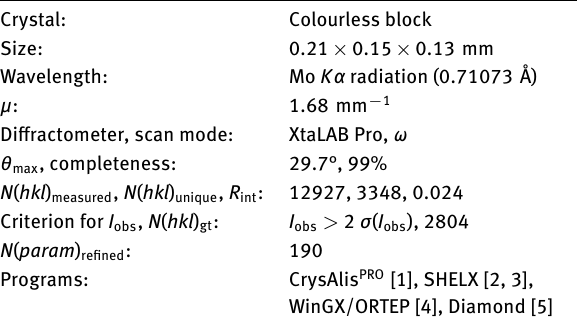
Table 1 contains crystallographic data and Table 2 contains the list of the atoms including atomic coordinates and dis- placement parameters.